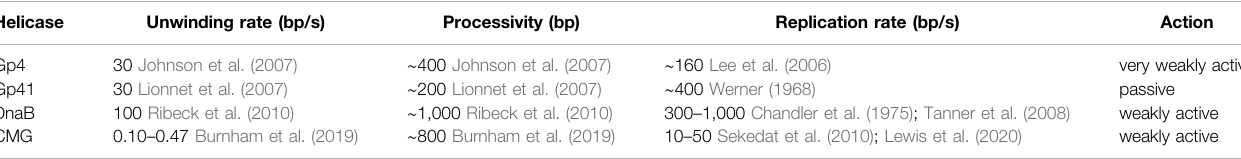
TABLE 1 | Replicative helicase rate and processivity parameters. For the replicative helicases gp4, gp41, DnaB, and CMG, from T7 phage, T4 phage, E. coli , and S. cerevisiae , respectively, the best estimates are given for the parameters of unwinding rate, processivity, replication rate, and predicted mode of action.